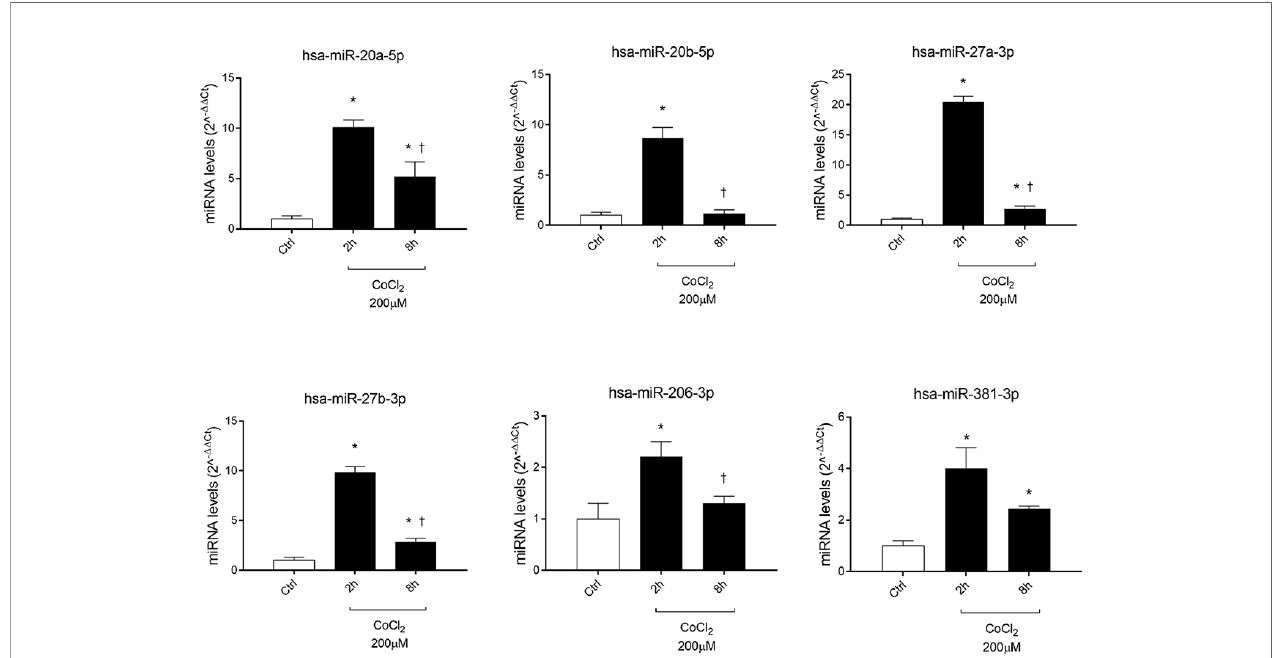
FIGURE 2 | Pattern expression of microRNAs (miRNAs) in human retinal endothelial cells (HRECs) treated with CoCl 2 , for 2 and 8 h treatment. Expression of miRNAs was analyzed with qRT-PCR. Each bar represents the mean value ± SD. *p < 0.05 200 µM CoCl 2 vs. control (ctrl); † p<0.05 8h vs. 2h CoCl 2 treatment;